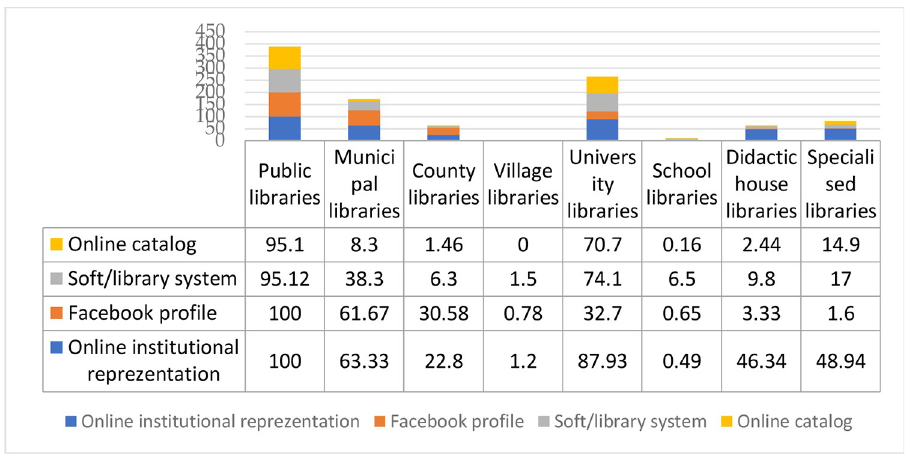
Fig 1. Synthetic representation of the types of libraries in Romania and their online presence: Facebook, specialized collection and user management software, online catalogue (CASIDRO data [2]).